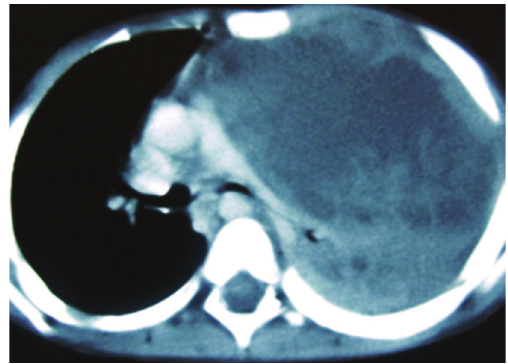
Figure 2: CT chest revealing a huge mass occupying the entire left hemithorax with mediastinal shift to opposite side (fat is not delineated nicely).